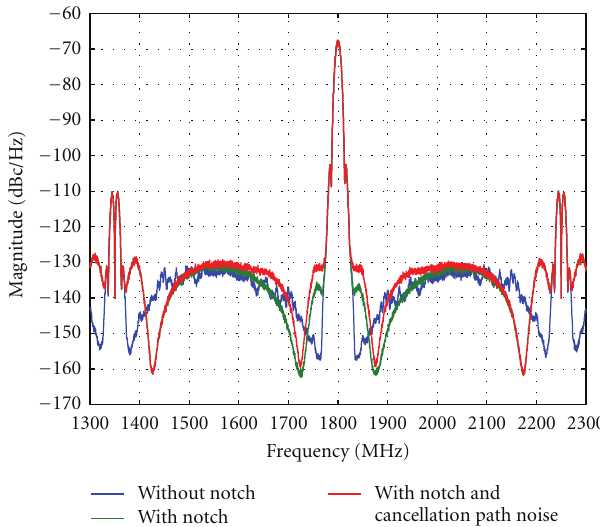
Figure 14: The simulated PSD of a GFSK-modulated signal before and after the inclusion of a notch at 80MHz o ff set. Degradation by 2dB is observed due to quantization noise in the cancellation